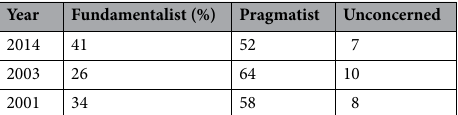
Table 2. Distribution of Westin’s categories for various